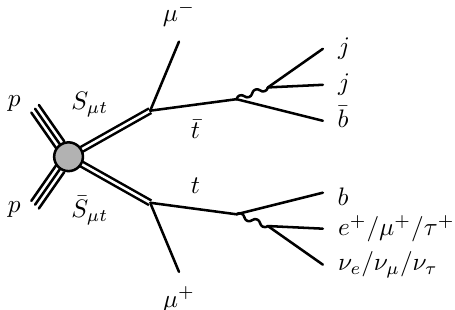
(cid:22) S + )((cid:22) t ! ( t (cid:22)t (cid:22)t l (cid:22) h (cid:22) (cid:0) ). Similar (cid:12)nal states and kinematics occur